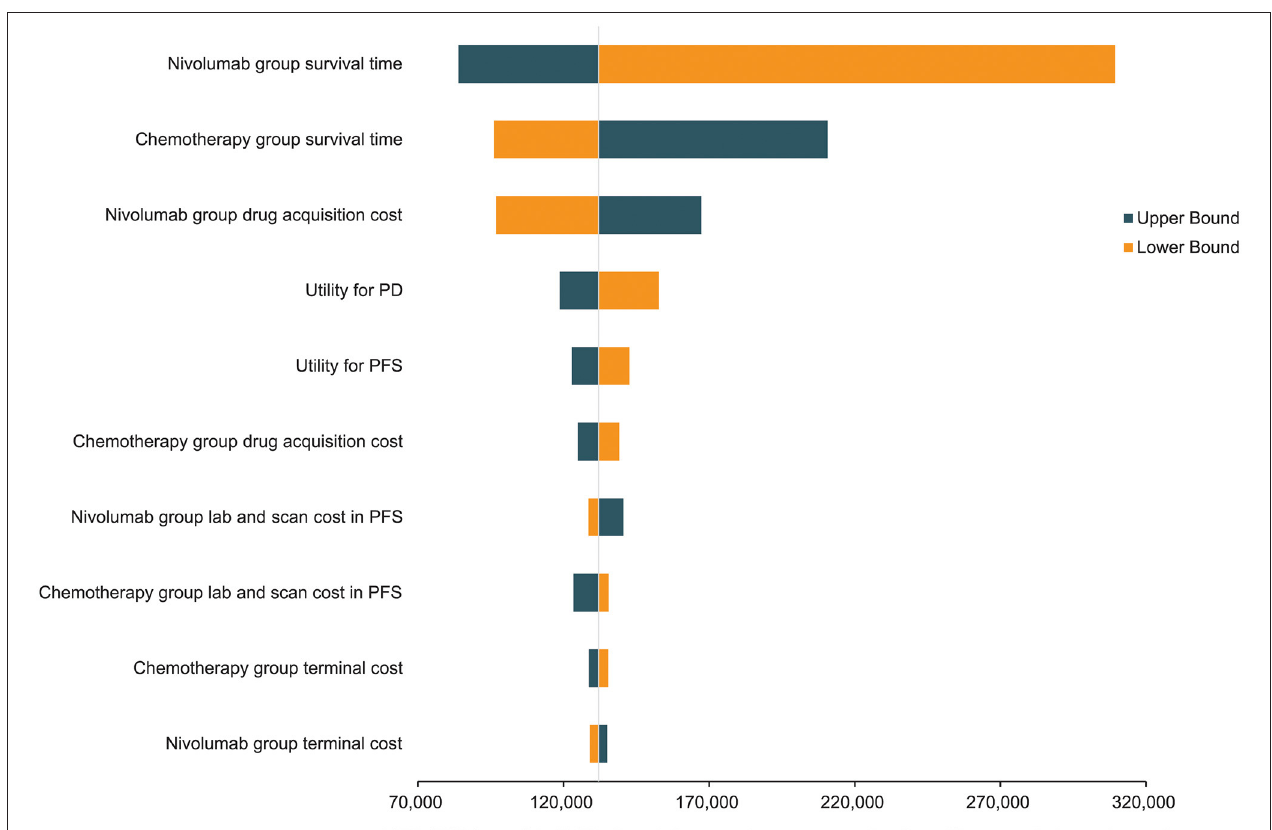
FIGURE 4 | The Top 10 most influencing parameters in Tornado